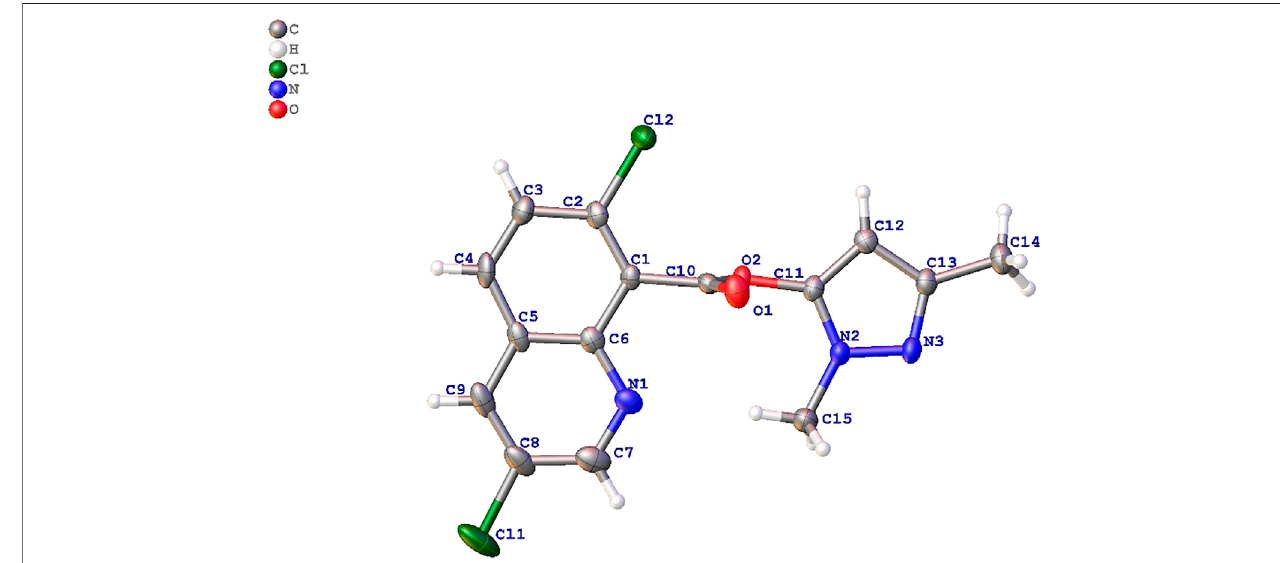
FIGURE 2 | Crystal structure of compound